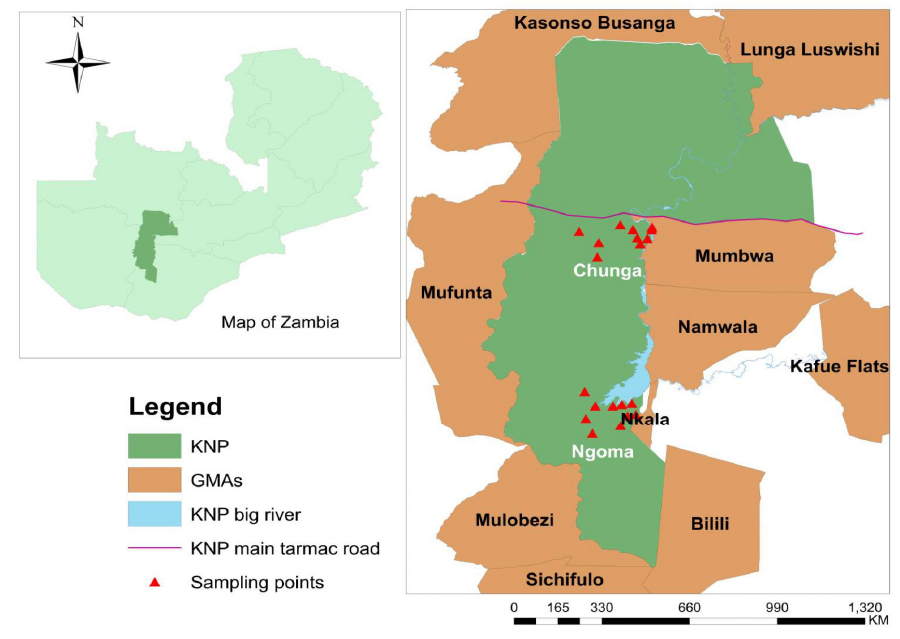
Figure 1. Map of the study area. Note: KNP = Kafue National Park, GMA = Game Management Area .